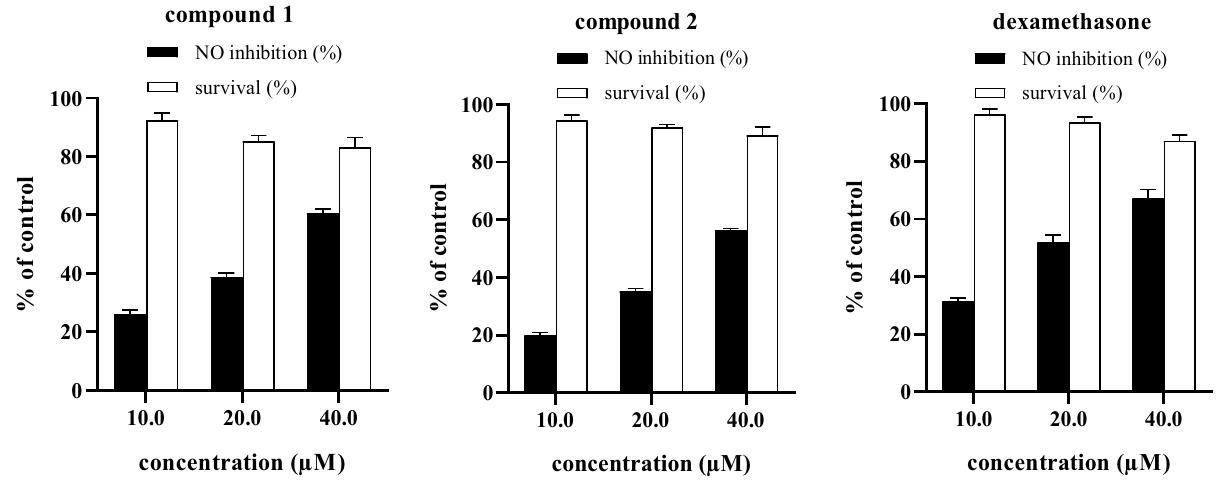
Figure 2: Concentration - response curve of samples on the NO inhibition and cell viability in RAW264.7 cells. Data are presented as mean value ± SD, n =